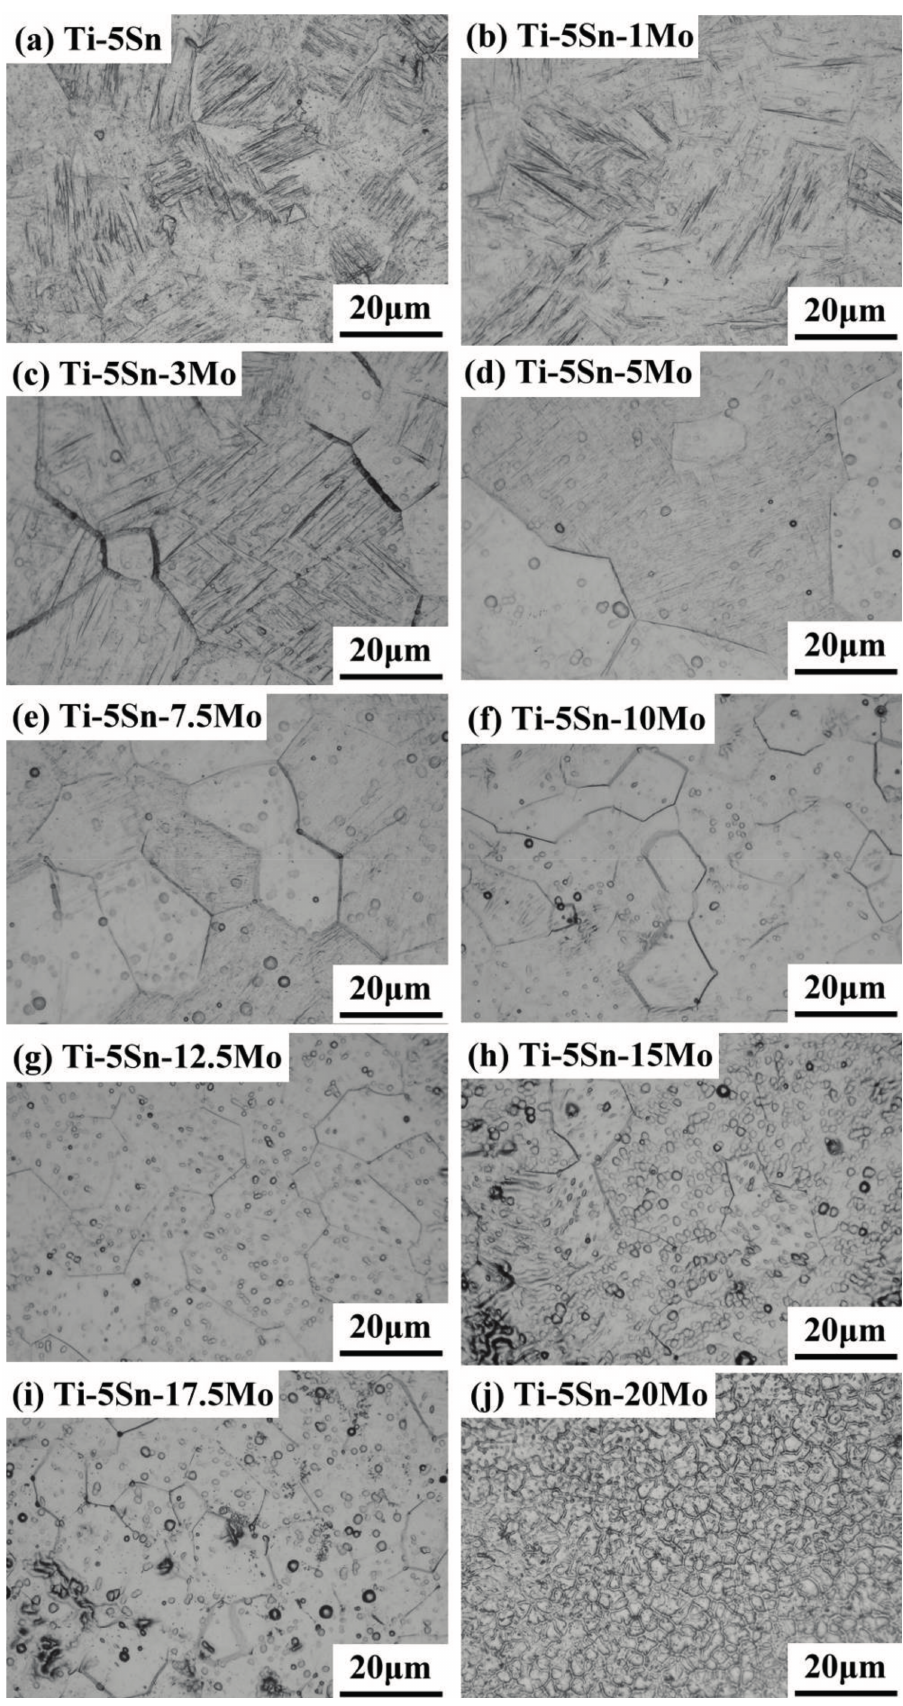
Figure 2. Light micrographs of as-cast Ti–5Sn and Ti–5Sn– x Mo